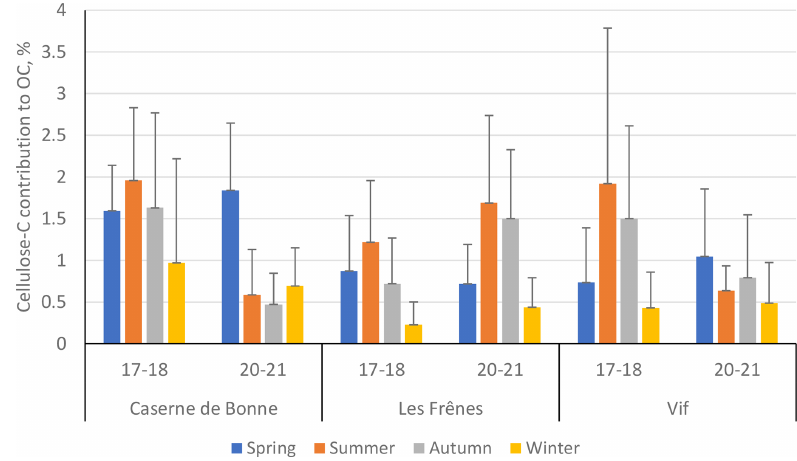
Figure 7. Percentage contribution of cellulose-derived carbon towards overall organic carbon (cellulose C to OC) across the three sites within the Grenoble metropole during the two separate sampling periods: 2017–2018 (17–18) and 2020–2021 (20–21). Black error bars represent 1 standard deviation of the seasonal means. Only positive error bars are shown to aid clarity. Seasons are defined as December–February (winter), March–May (spring), June–August (summer), and September–November (autumn). Site classifications are as follows: urban for Caserne de Bonne, urban background for Les Frênes, and peri-urban for